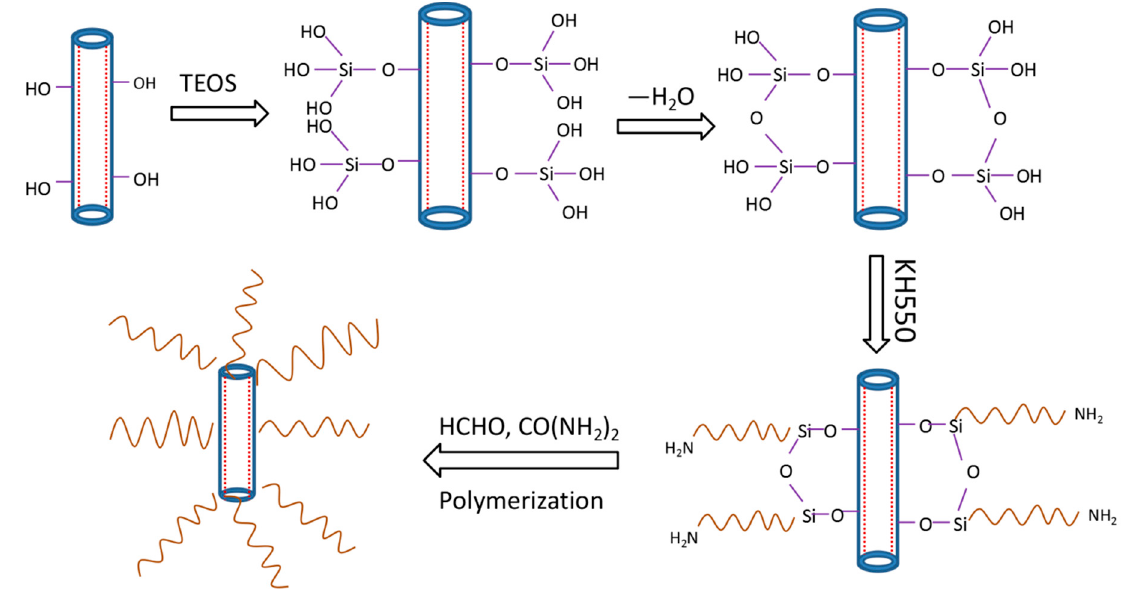
Figure 8. The mechanism to the formation of UF/TH-HNTs nanocomposites.